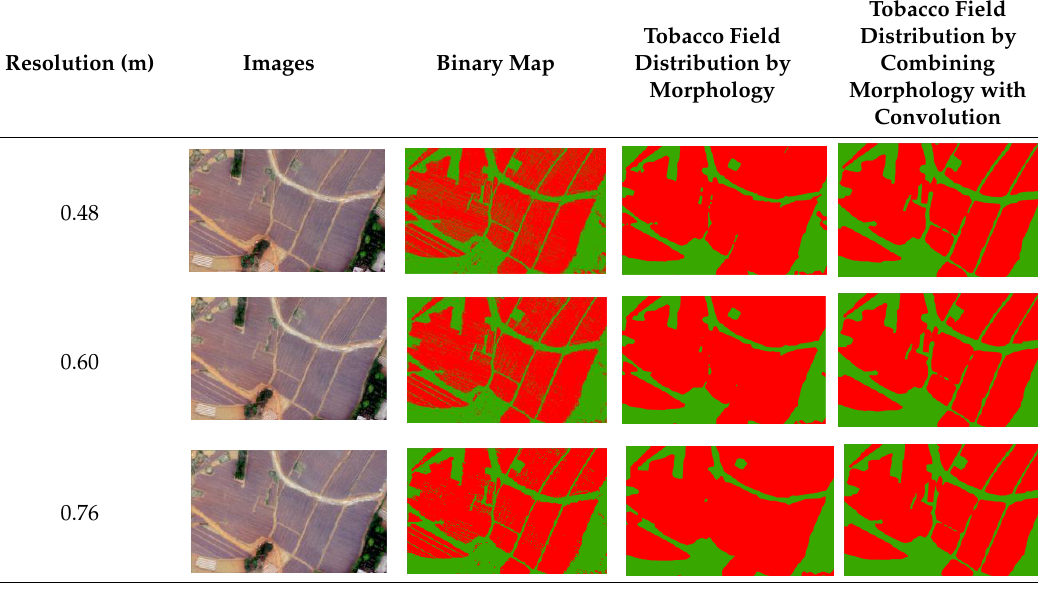
Table 3. Accuracy and parameters of tobacco field identification by using different image ground sampling distance (GSD).